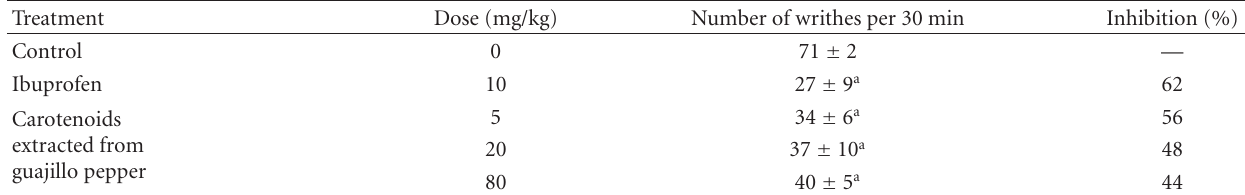
Table 4: The e ff ect of pigments extracted from guajillo pepper on acetic acid-induced writhing test in mice. Treatment